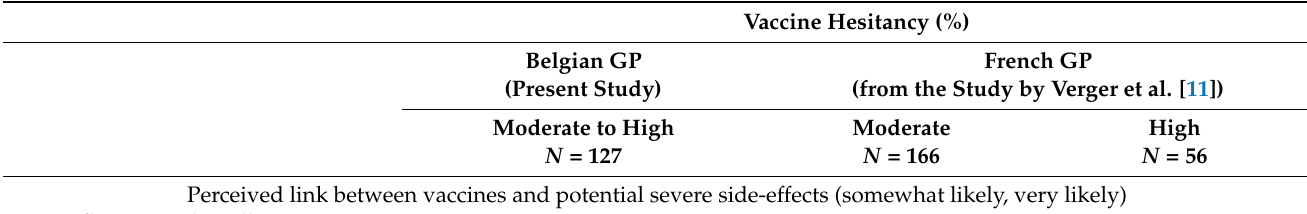
Perceived link between vaccines and potential severe side-effects (somewhat likely, very likely) Influenza and Guillain-Barr